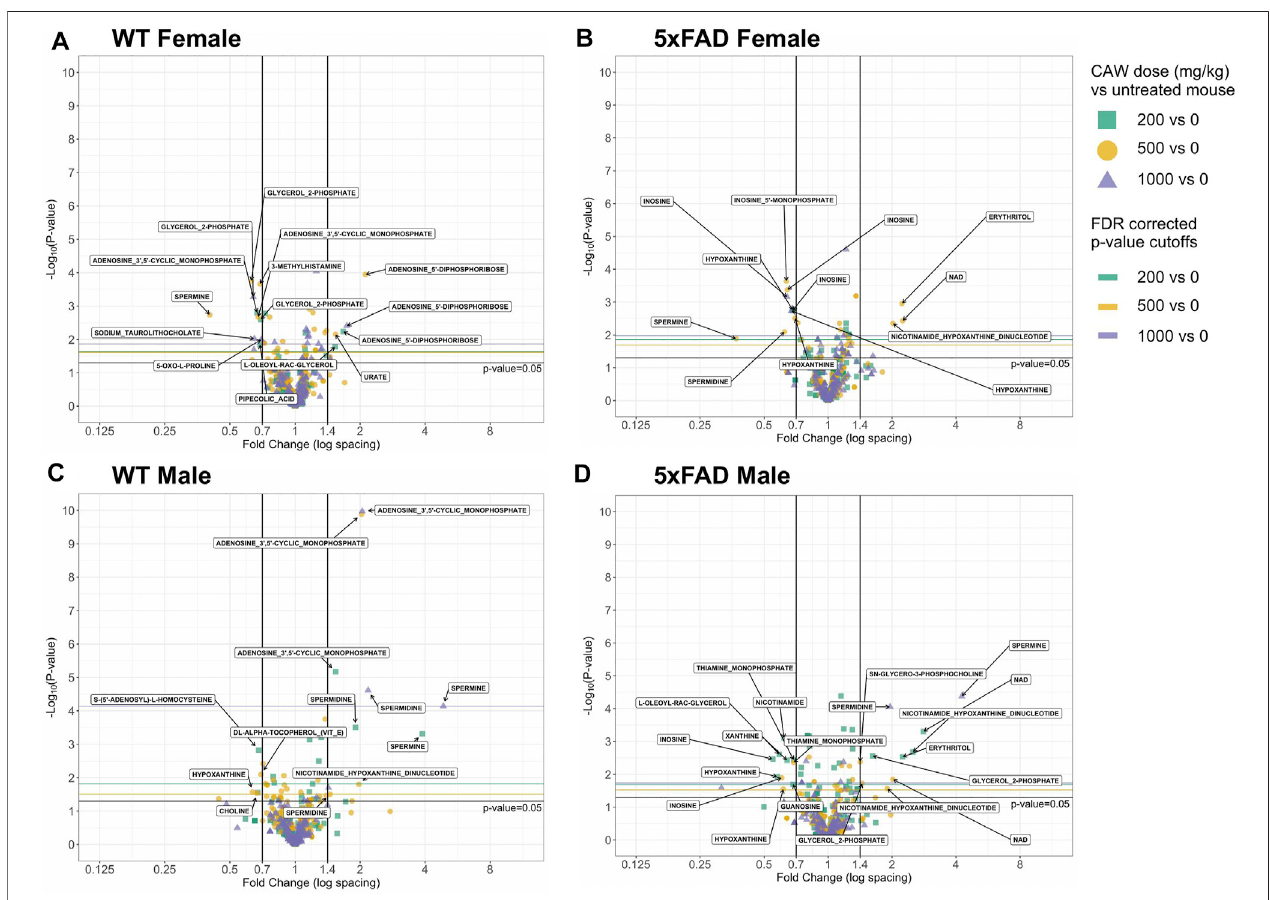
FIGURE 6 | Volcano plots of cortical metabolites female and male wild-type (WT) and 5xFAD mice treated with CAW (200, 500 or 1,000 mg/kg) compared to untreated sex- and genotype-matched mice.